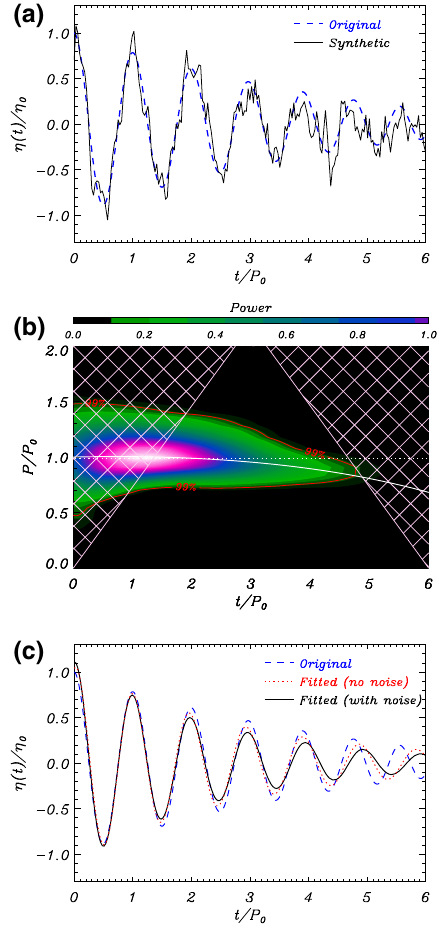
transverse inhomogeneity length scale, Soler et al. (2012) used the created synthetic data to perform a statistical study of the inferred values for this parameter. Their results indicate that this parameter can be overestimated when the presence of flows is not considered. Figure 92 shows histograms containing 10 4 data realisations for three val- ues of the flow speed. By visual inspection, the histograms seem to follow a Gaussian distribution. By performing the corresponding fittings, Soler et al. (2012) find that as the flow velocity increases, the mean values are shifted towards larger values of l / R . The widths of the Gaussians are however rather unaffected by the considered flow velocities. These results indicate that neglecting mass flows can have a relevant impact on the seismologically inferred values for the